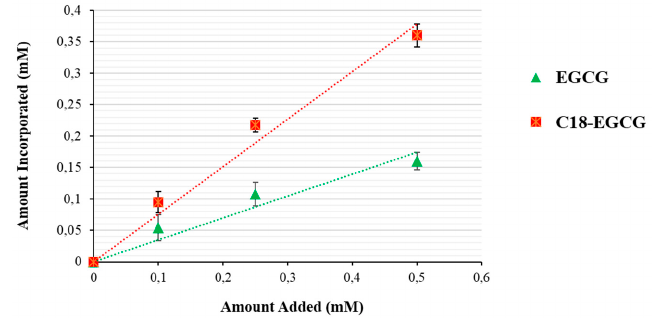
Figure 4. Methanol solutions of EGCG (green) and C18-EGCG (red) (0.1 mL) were added to liposomal suspensions (0.9 mL). Folin-Ciocalteu method was used to determine the antioxidant amount incorporated into liposomes. The values in the figures are expressed as the means ± SD; n = 5 independent experiments.